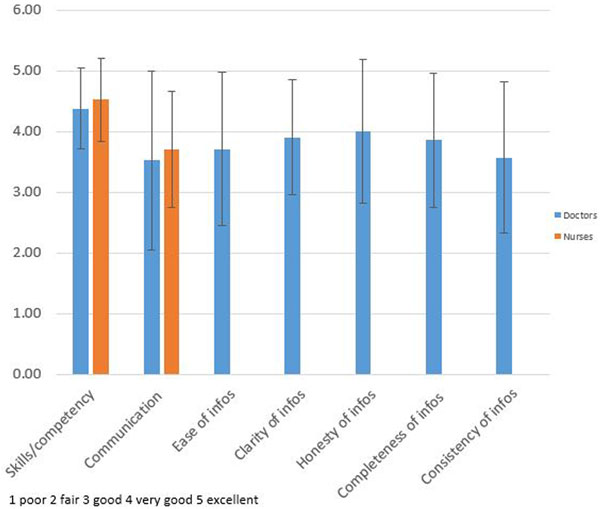
Team performance.